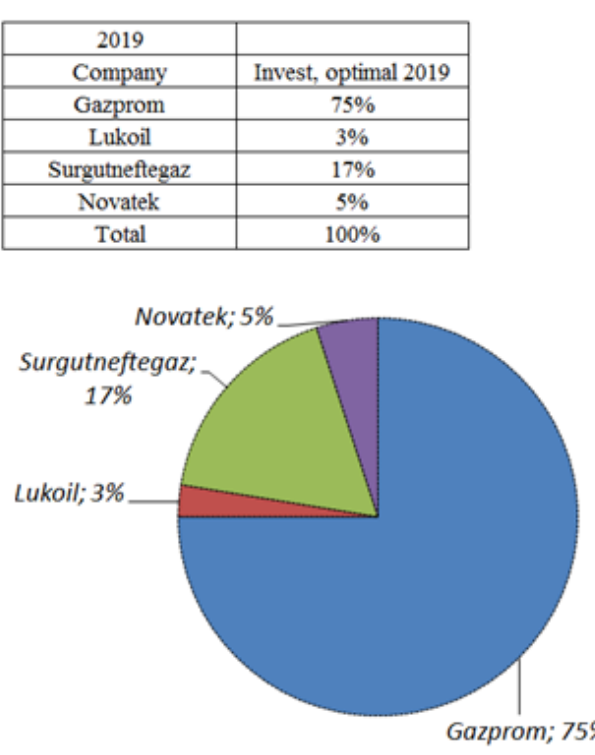
Figure 4. Optimal capital by model (8)–(9).